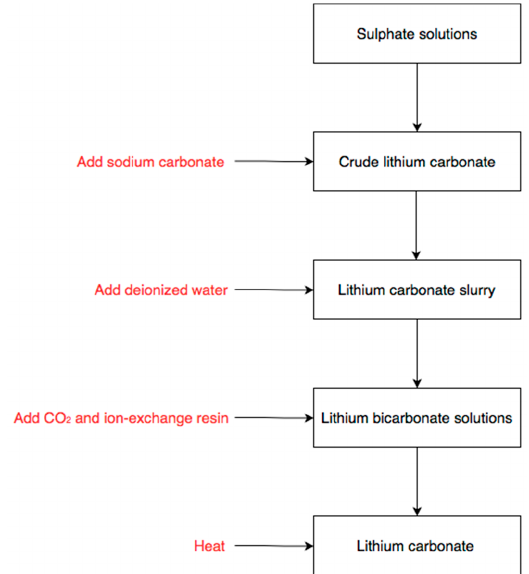
Figure 1. The outline of the purification process for lithium carbonate from sulphate solutions.